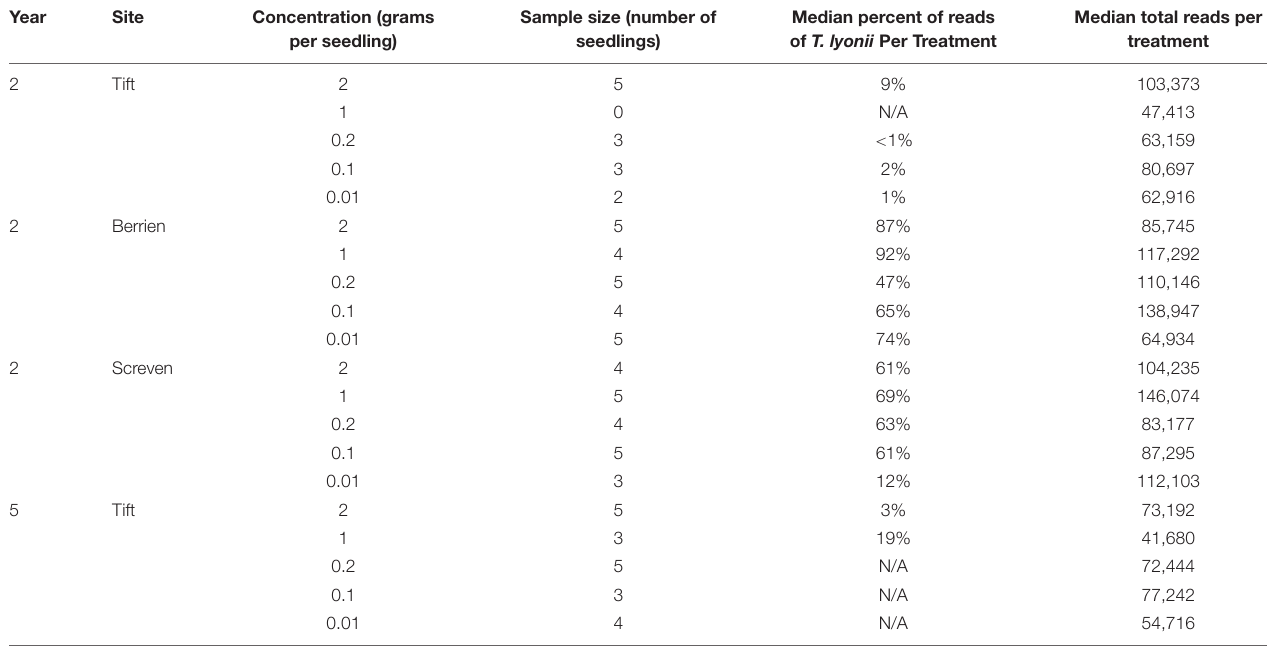
TABLE 4 | Year, site, treatment, sample size, median percent of T. lyonii reads per treatment, and median total reads per treatment for all fungi from the concentration rate experiment (year 2 = 2015, year 5 = 2018). Year Site Concentration (grams Sample size (number of Median percent of reads Median total reads per per seedling) seedlings) of T. lyonii Per Treatment treatment